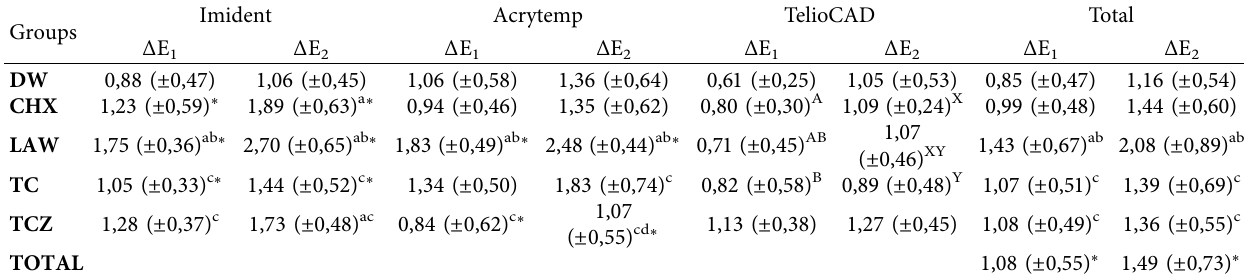
Table 1: Δ E values of the materials after immersion in solutions and mean ( ± standard deviation) values ( p < 0 . 05).